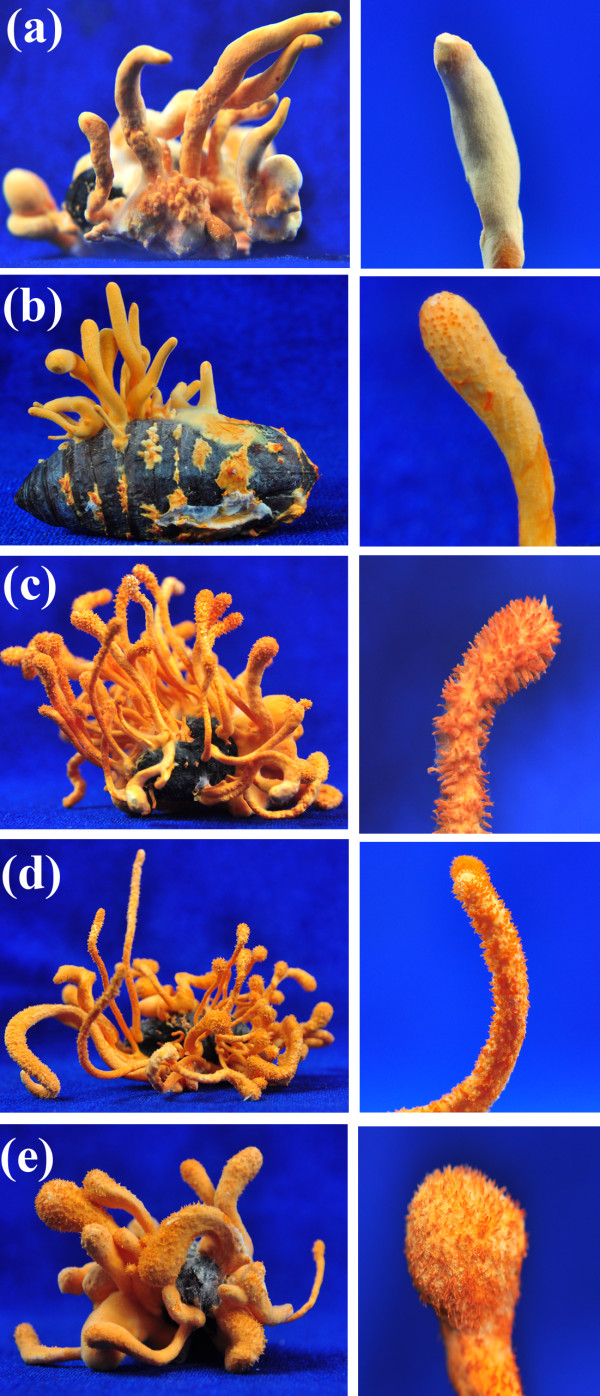
Fruiting structures of different mating-type isolates. (a, b) Sterile fruiting bodies formed on caterpillar pupae after inoculation of MAT1-1 (a) and MAT1-2 (b) isolates acquired by single conidial spore isolation from a MAT1-1/MAT1-2 hybrid strain, Cm06. (c-e) Fertile fruiting structures formed on caterpillar pupae after inoculation of the mixed conidia of MAT1-1 (Cm01) and MAT1-2 (Cm06) at ratios of 1:9 (c), 1:1 (d) and 9:1 (e), respectively. The right panels represent close-up views of corresponding sterile (without protruded perithecia) or fertile (with protruded perithecia) fruiting bodies. After inoculation, the pupae were incubated at 22°C with a 12:12 hour light:dark cycle for 60 days.